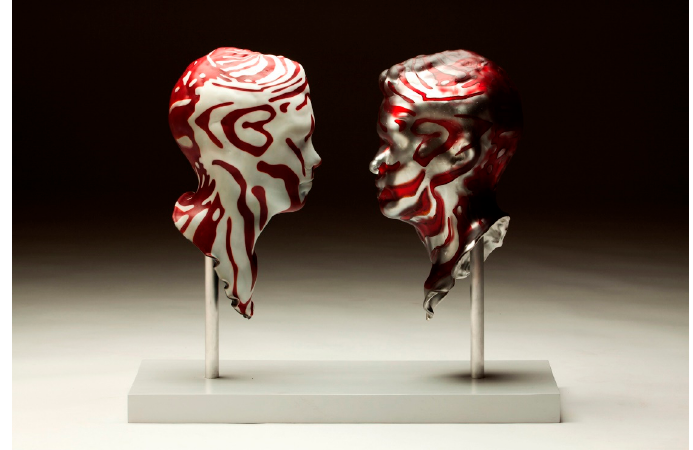
Figure 1. Portrait of the Artist: Invasive Redaction 17-05-13: Pterois volitans , Davin K. Ebanks. Water-jet cut, Mold-blown, Hot-sculpted and Silvered Glass, Aluminum, Wood. 18H × 20W × 10D inches. 2011. [Created by author].